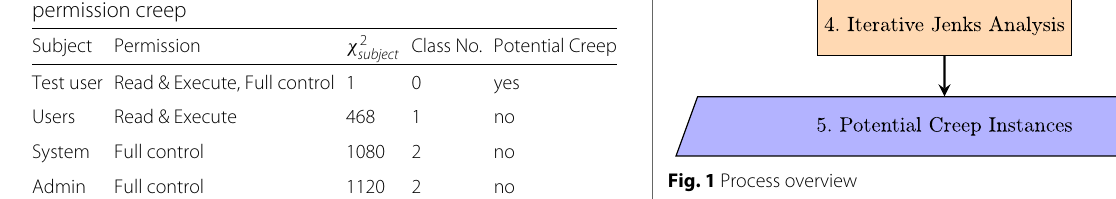
Table 1 Scores form analysing a directory structure where